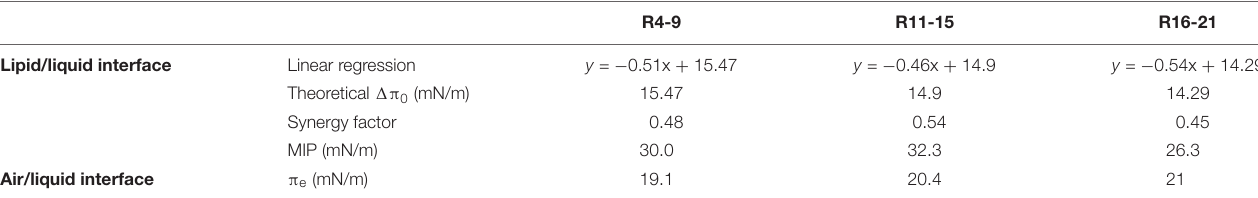
R4-9 R11-15 R16-21 Lipid/liquid interface Linear regression y = − 0.51x +